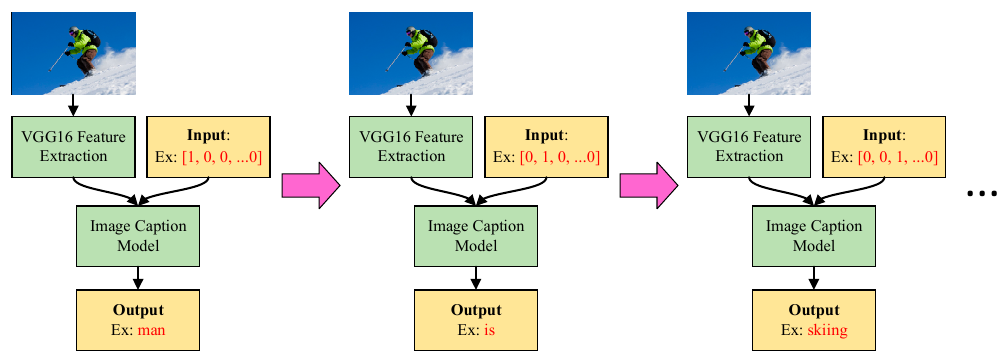
Figure 8. Workflow of the designed Image caption model.